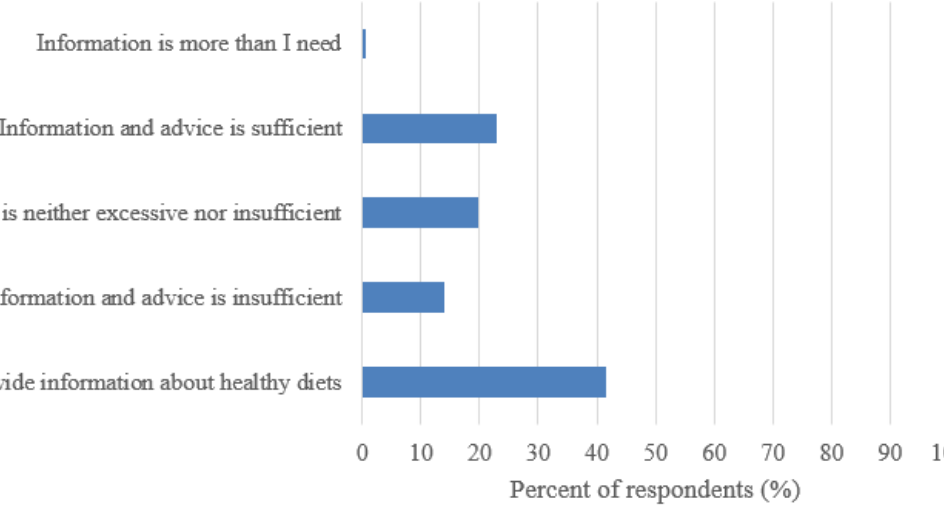
Figure 2. First year Canadian and US veterinary students’ response to the question, ‘What is your view on the quality / quantity of information provided about healthy diets by your family doctor?’ on a questionnaire that assessed health and nutrition attitudes and behaviours